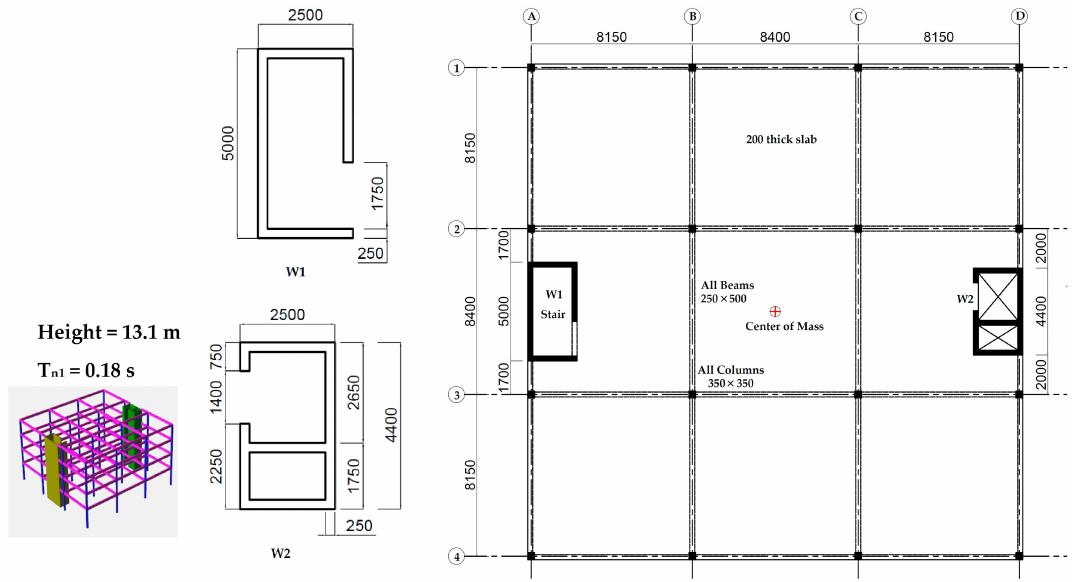
Figure 16. Floor plan, structural layout, and elevation view of CSB 6 (all dimensions are in